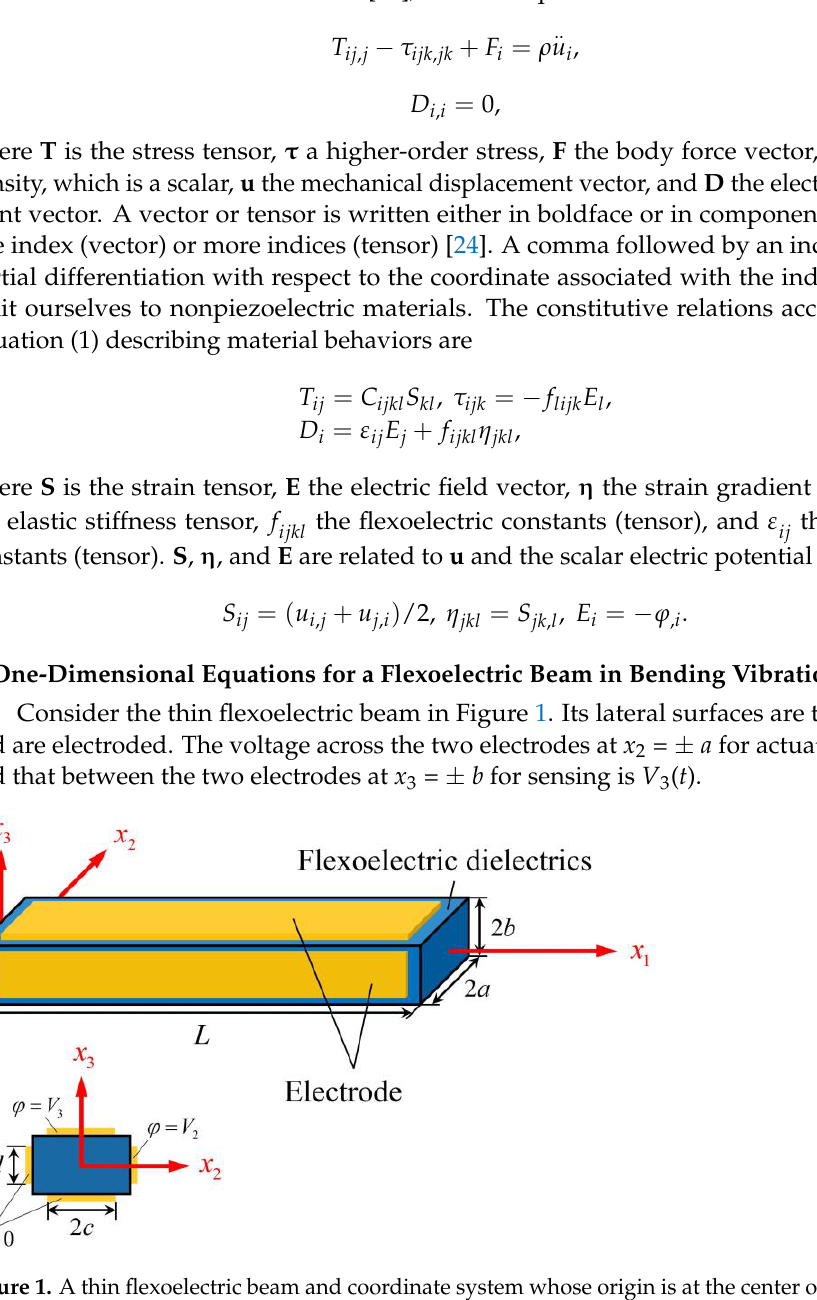
Figure 1. A thin flexoelectric beam and coordinate system whose origin is at the center of the left